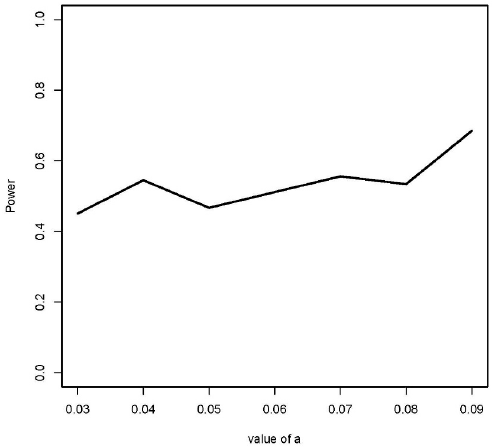
Figure 5. Estimated power for the alternative case #1. Solid line (option 1), dashed line (option 2) and dotted line (option 3).